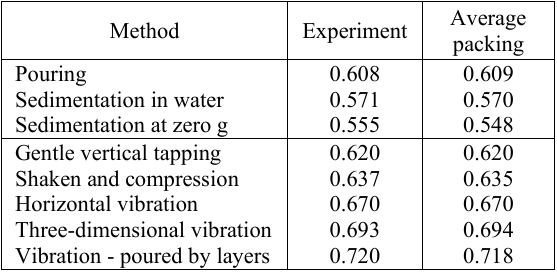
Table 1. Comparison of packing